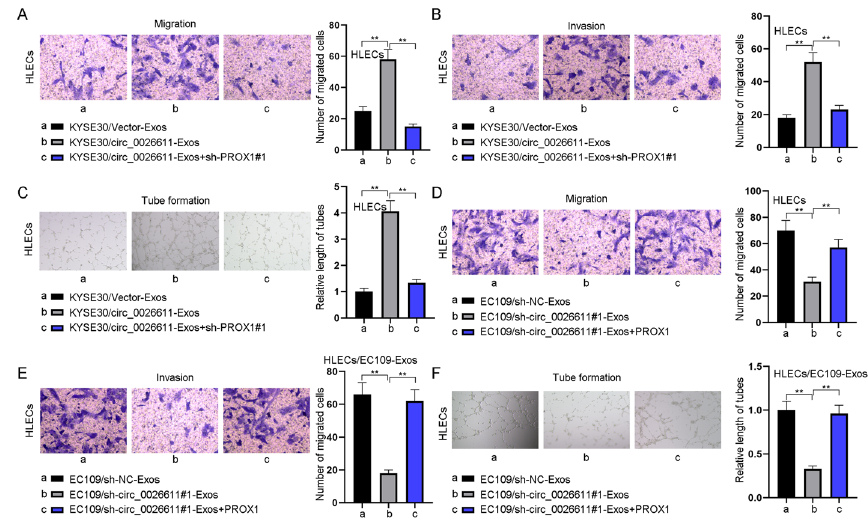
Fig. 4 ESCC exosomal delivery circ_0026611 promoted lymphangiogenesis by regulating PROX1. A – C HLECs were divided into three groups. The first group was treated with exosomes derived from KYSE30 cells transfected with vector. The second and third groups were treated with KYSE30-derived exosomes with circ_0026611 overexpression vector, but the third group was also transfected with sh-PROX1#1 at the same time. The cell migration, invasion, and tube formation in the three groups were assessed via functional assays. D – F HLECs were divided into three groups. The first group was treated with exosomes derived from EC109 cells transfected with sh-NC. The second and third groups were treated with EC109-derived exosomes with circ_0026611 inhibiting vector, but the third group was also transfected with pcDNA3.1-PROX1 at the same time. Transwell assay and tube formation assay were carried out to detect the cell migration, invasion, and tube formation in the three groups. ** P <